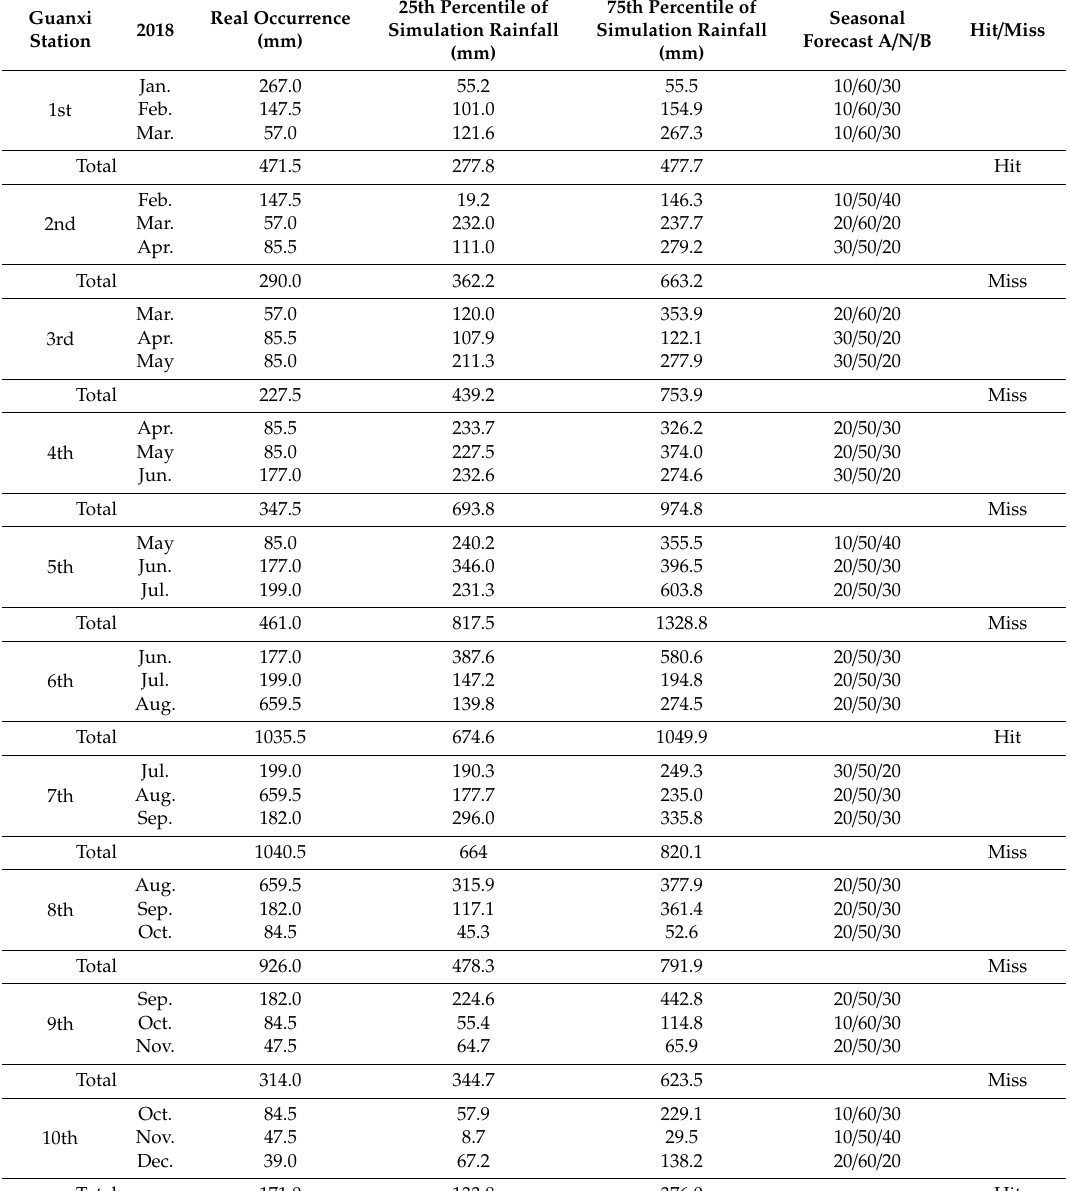
Table 3. Ten sets of seasonal rainfall outlooks and real rainfall occurrences of Guanxi station in 2018. Guanxi